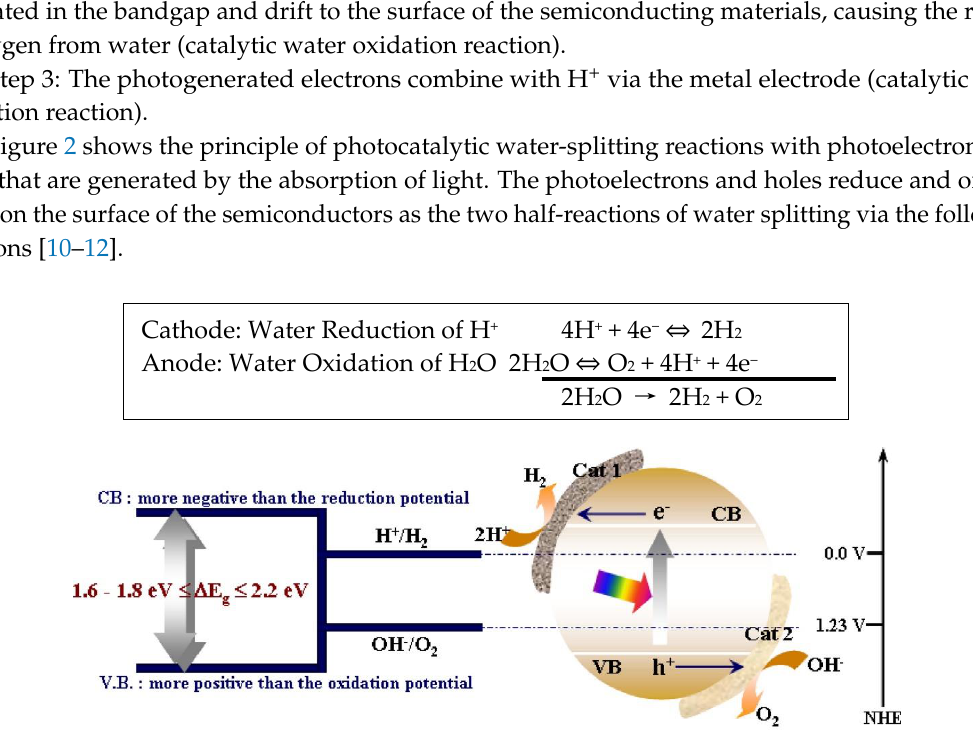
Figure 2. Principle of photocatalytic water-splitting (PC) reactions [7]. Copyright 2014, Elsevier.